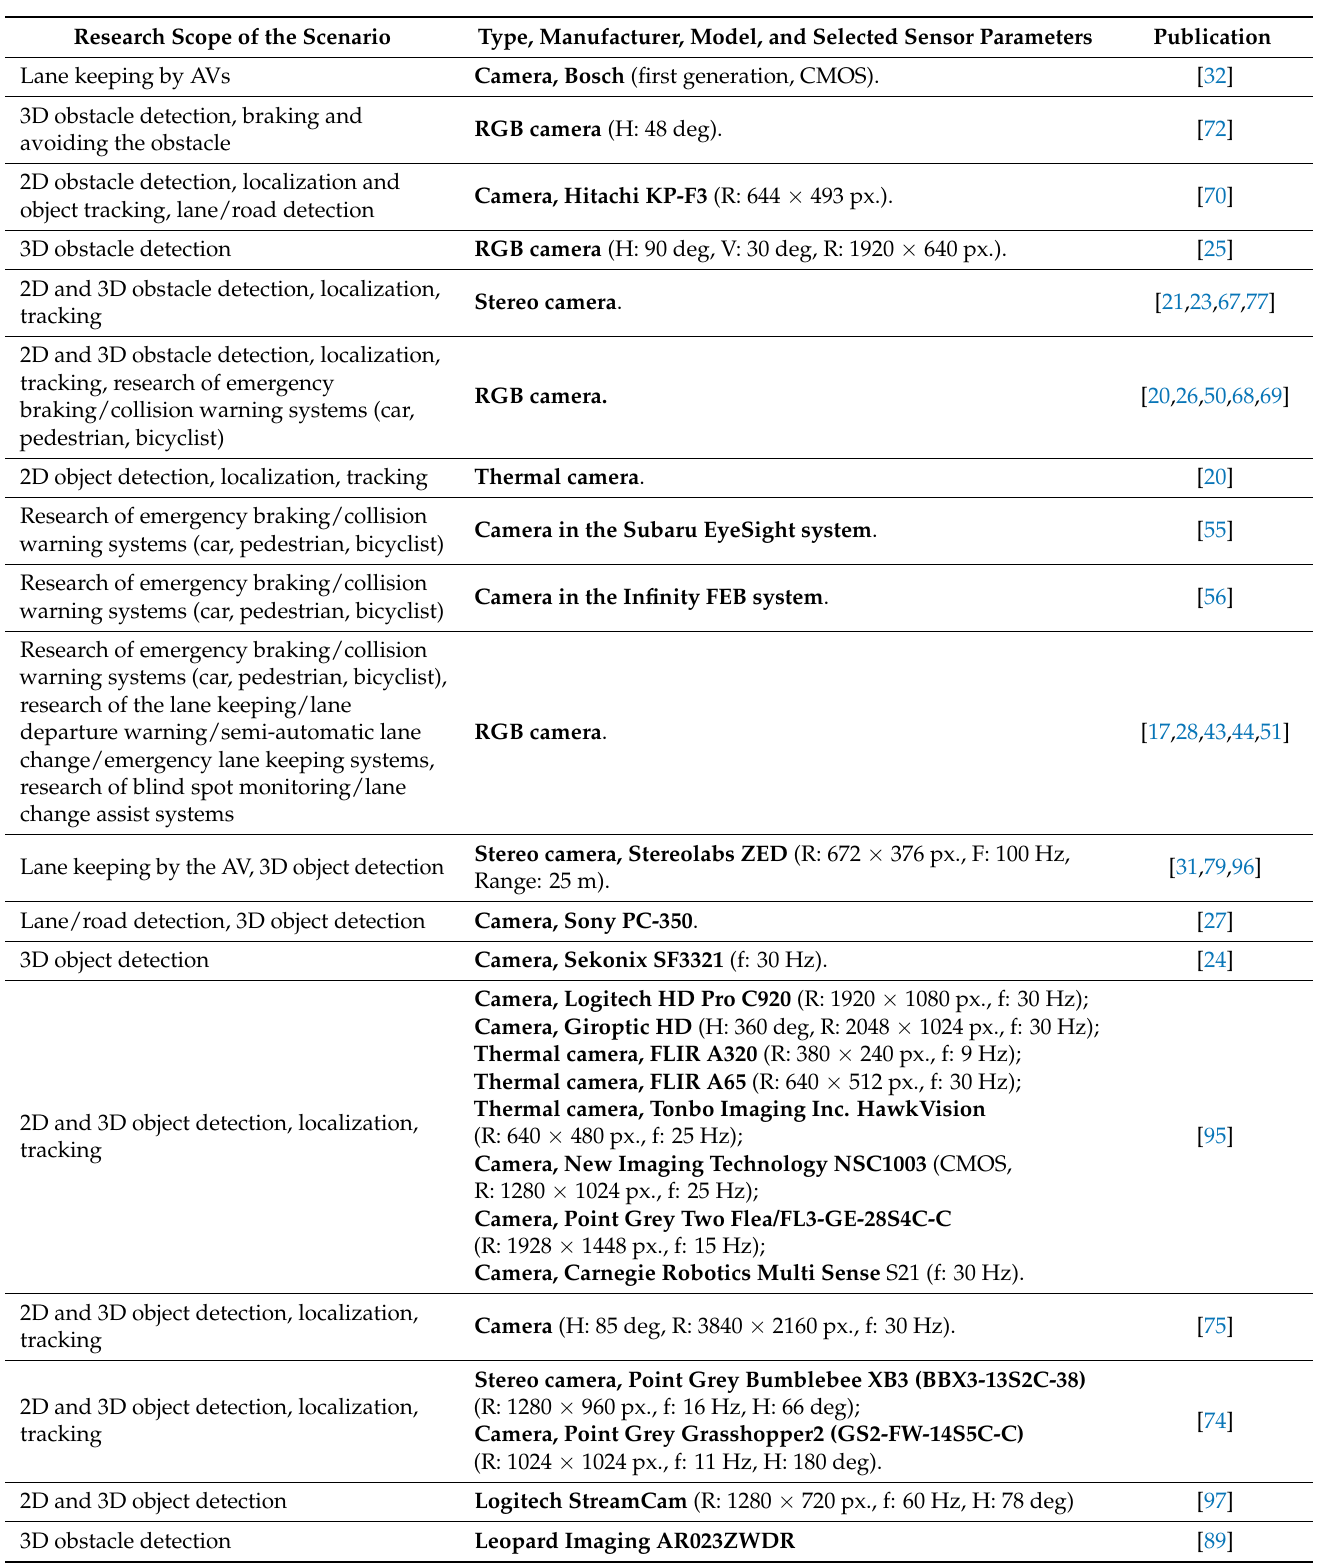
Table 7. Cameras used in perception and control systems during AV